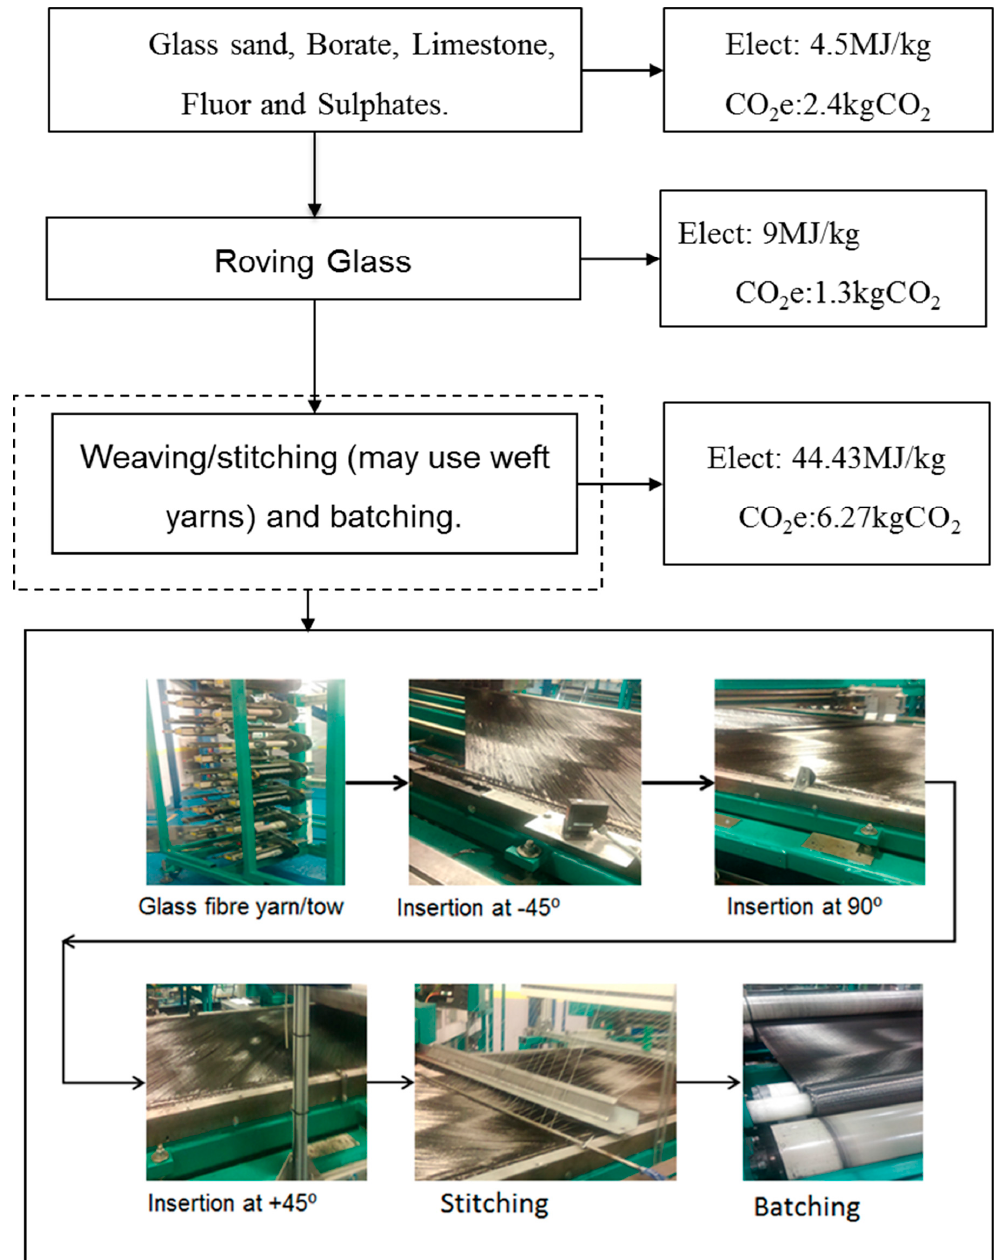
Figure 4. System boundary manufacturing process of multiaxial glass fibre to produce structure fabrics at Formax.